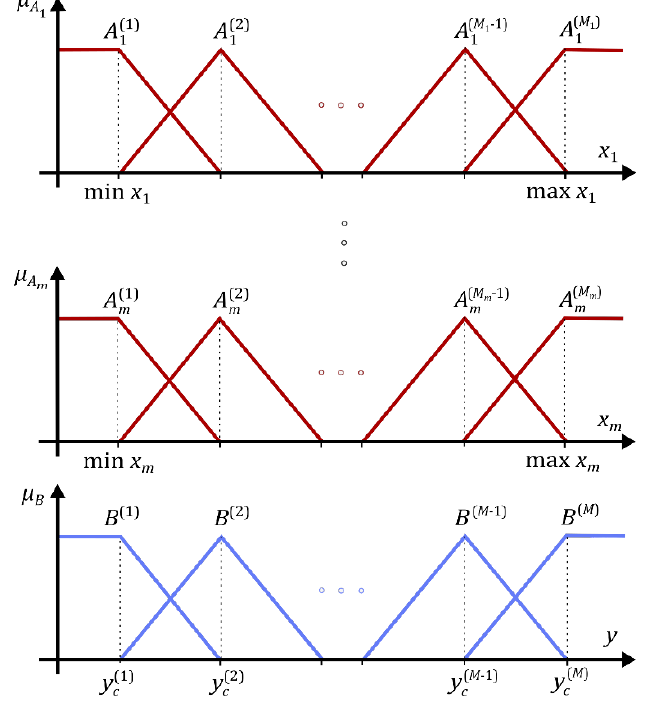
Figure 2. Membership functions of the FS with m inputs x and one output y